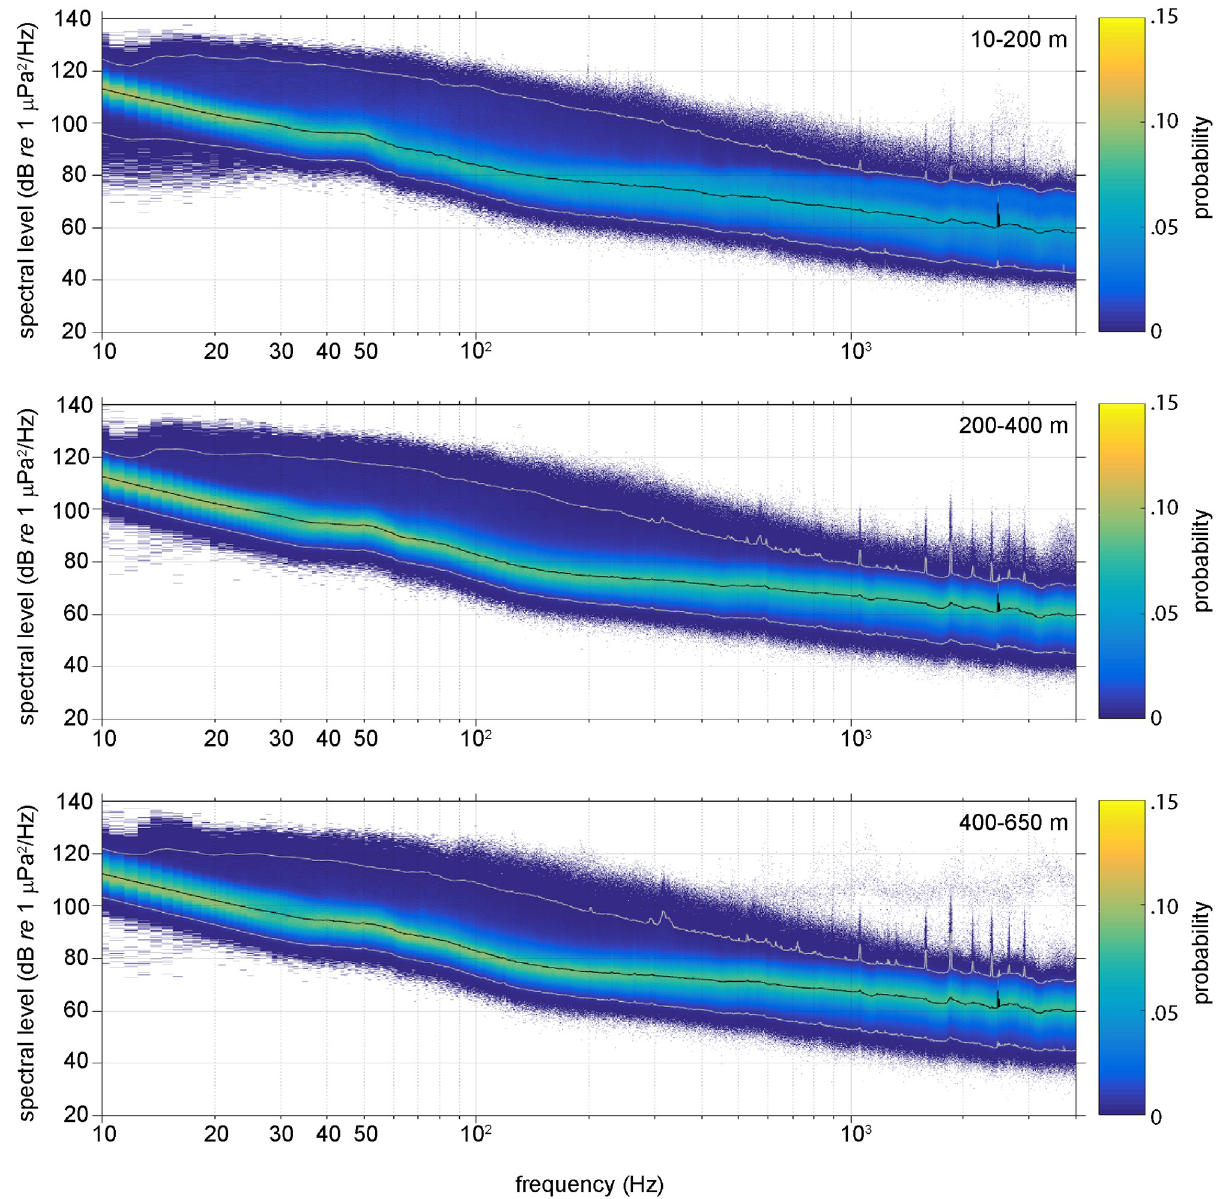
Fig 4. Spectral probability distributions (SPD) of acoustic energy in 3 depth intervals. SPDs calculated from 4 second hann windows, no overlap, as recorded by the glider at 3 distinct depth intervals; shallow (10–200 m); mid (200–400 m); and deep (400–650 m). Median (50 th percentile) values shown as black lines and 99 th and 1 st percentiles shown as white